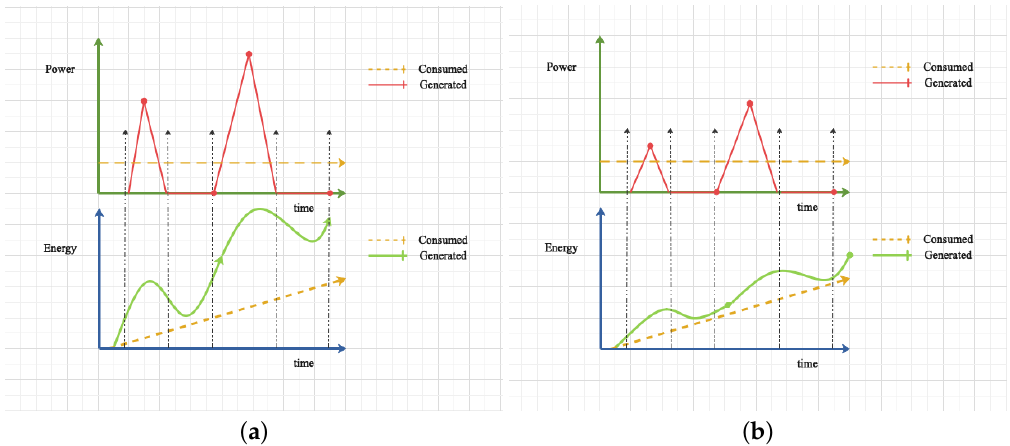
Figure 7. Power Management: ( a ) Continuous operation mode. ( b ) Discontinuous operation